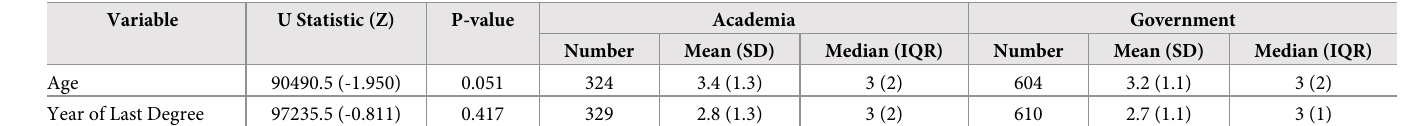
��� Statistically significant at P � 0.001 (Chi-square tests).